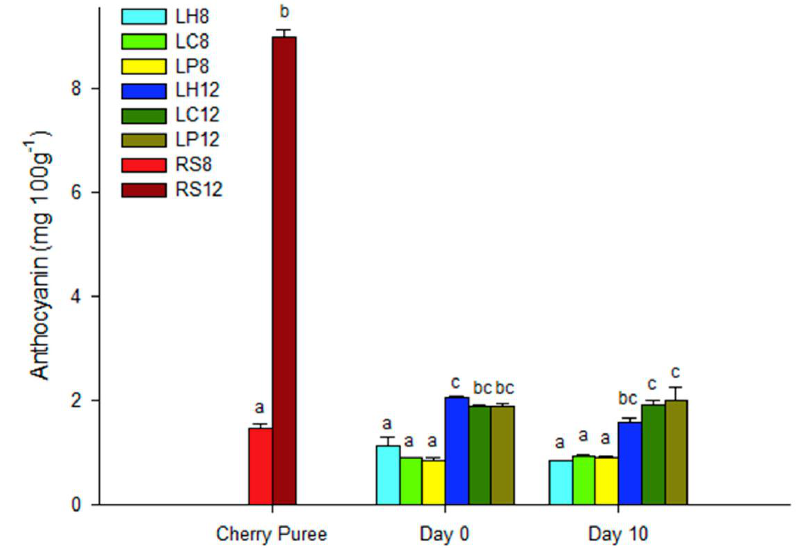
Figure 2. Concentration of total anthocyanins (mg 100 g −1 ) of sweet cherry puree before incorporation